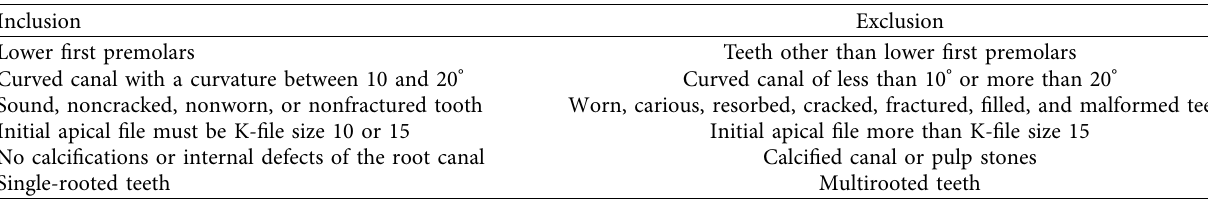
Figure 1: Lower first premolar with a 11 ° curvature that matched the teeth selection criteria in this study. Table 1: Inclusion and exclusion criteria used in this